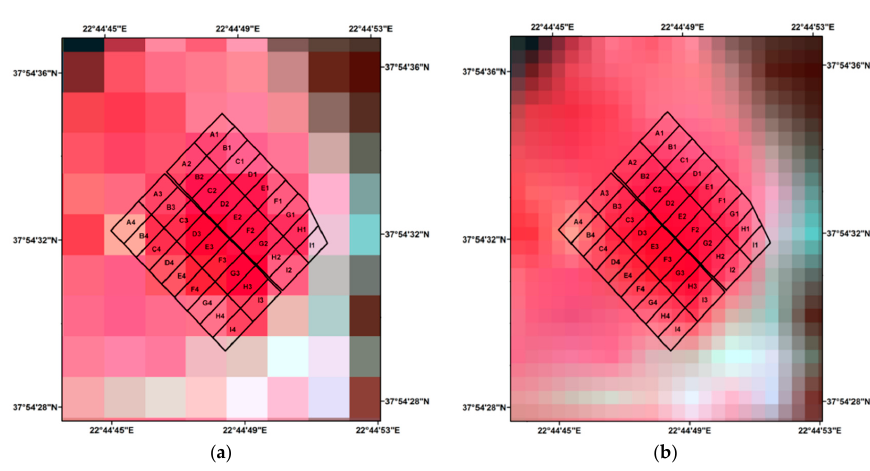
Figure 2. Landsat 8 false color images with ( a ) 30 m and ( b ) 10 m resolution.